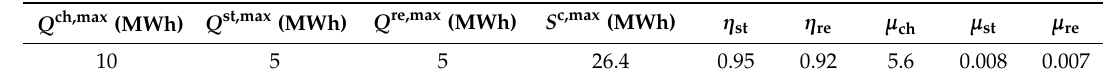
Table A2. Parameters of the CACS.